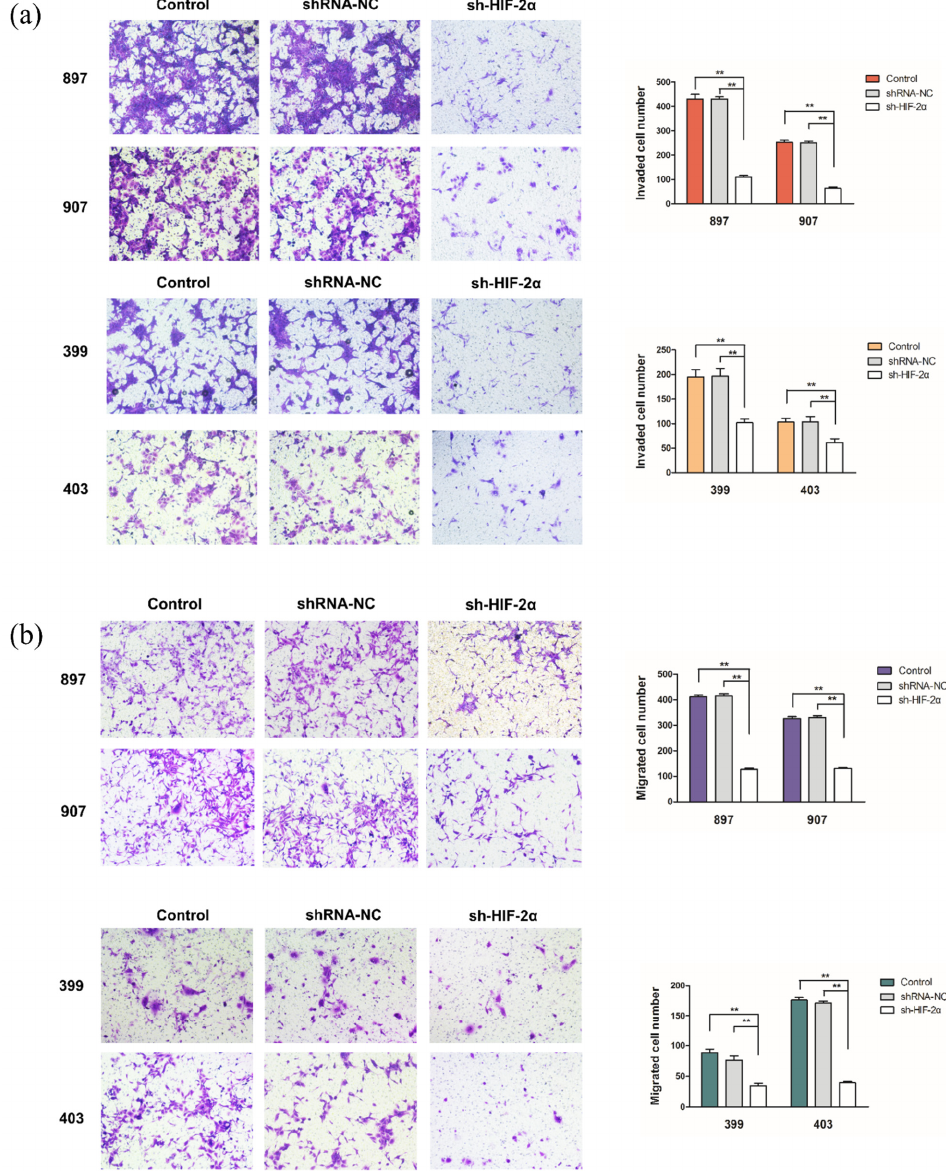
Figure 5. HIF-2 α knockdown inhibits the invasion and migration of Kras G12D and Kras G12D -LOH PDAC cells. Kras G12D and Kras G12D -LOH PDAC cells were transfected with sh-HIF-2 α and shRNA-NC. ( a , b ) The invasion and migration capacity of Kras G12D and Kras G12D -LOH cells according to Transwell assays. Data are expressed as the mean ± SD, based on three independent experiments. ** p < 0.01.